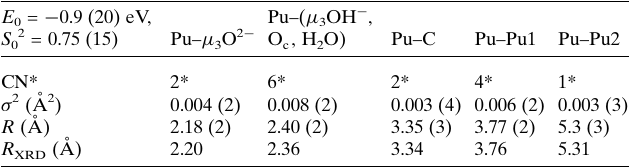
Table 3 EXAFS refined metrical parameters obtained for the best fit of the soluble Pu–DOTA hexanuclear clusters. CN is the coordination number. Errors in brackets only reflect the mathematical uncertainty provided by the proposed model. Asterisks (*) indicate fixed values.